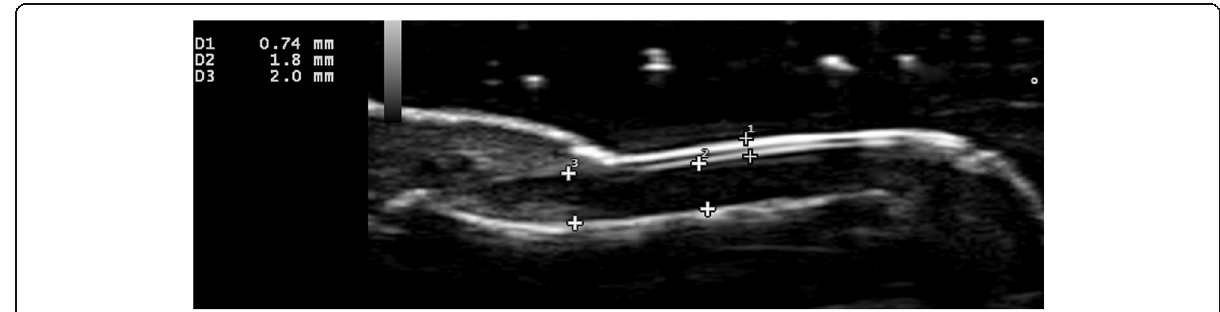
Fig. 3 Measures of nail plate, nail bed and nail matrix thickness in US gray scale. Legend: Nail plate thickness measure (1); nail bed thickness measure (2) and nail matrix thickness measure (3). Authors ’